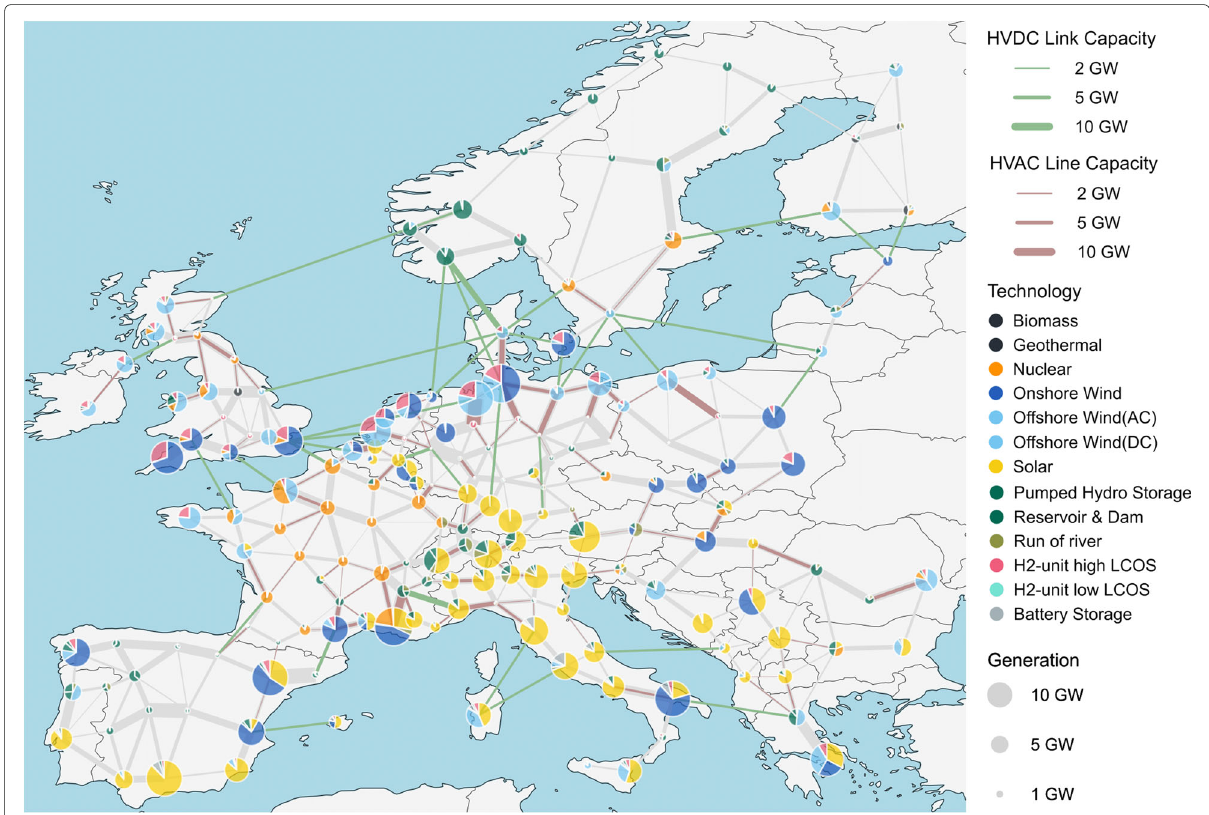
Fig. 4 Optimal generation, storage and network expansion under a 100% emission reduction scenario and technology data for 2030. Light grey lines showing the existing installed network capacity, dark grey lines the additional expanded capacity. Plot produced with